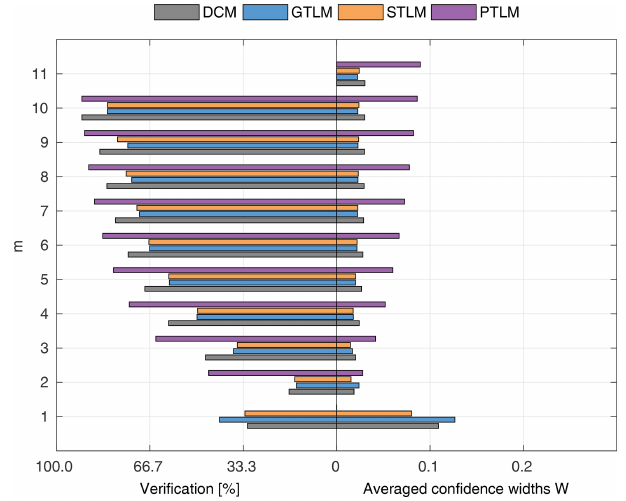
Figure 14. Percentage of the verification set ( M − m ) enclosed by confidence intervals and average width of confidence intervals for different numbers of data points for model identification ( m ); results shown for the identifiable models for Ritobacken, spring 2012.